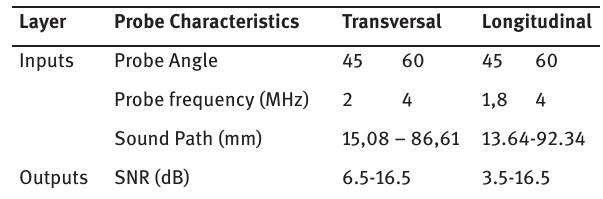
Table 5.: Test probes and sound path length of